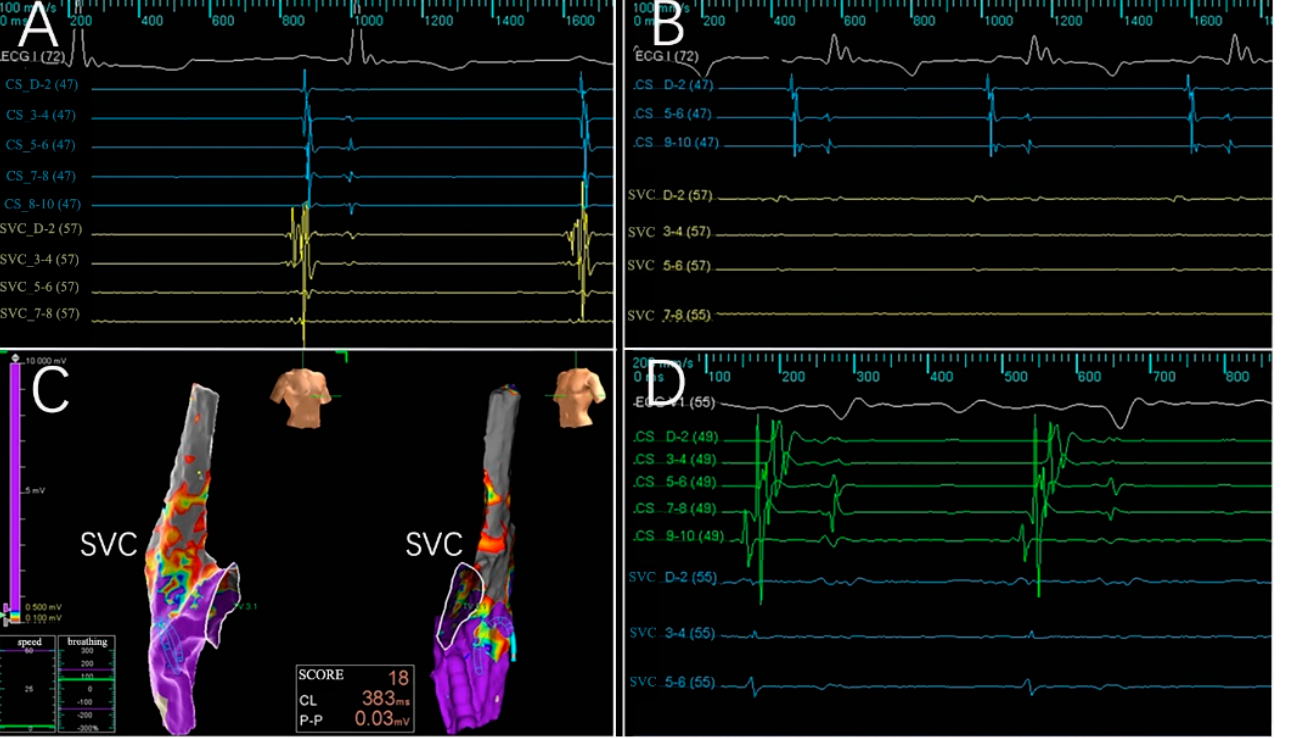
Figure 5. Electrophysiologic evaluation of the SVC treatment with PFA is shown. Electrograms for the SVC were reduced after the trains were delivered. ( A , B ) Electrograms before and after PFA; complete electrical isolation was confirmed by the entrance block. ( C ) A chronic map demonstrating isolated SVC. ( D ) Electrograms 4 weeks after PFA. ECG:electrocardiogram; CS: coronary vein sinus; SVC: superior vena cava.